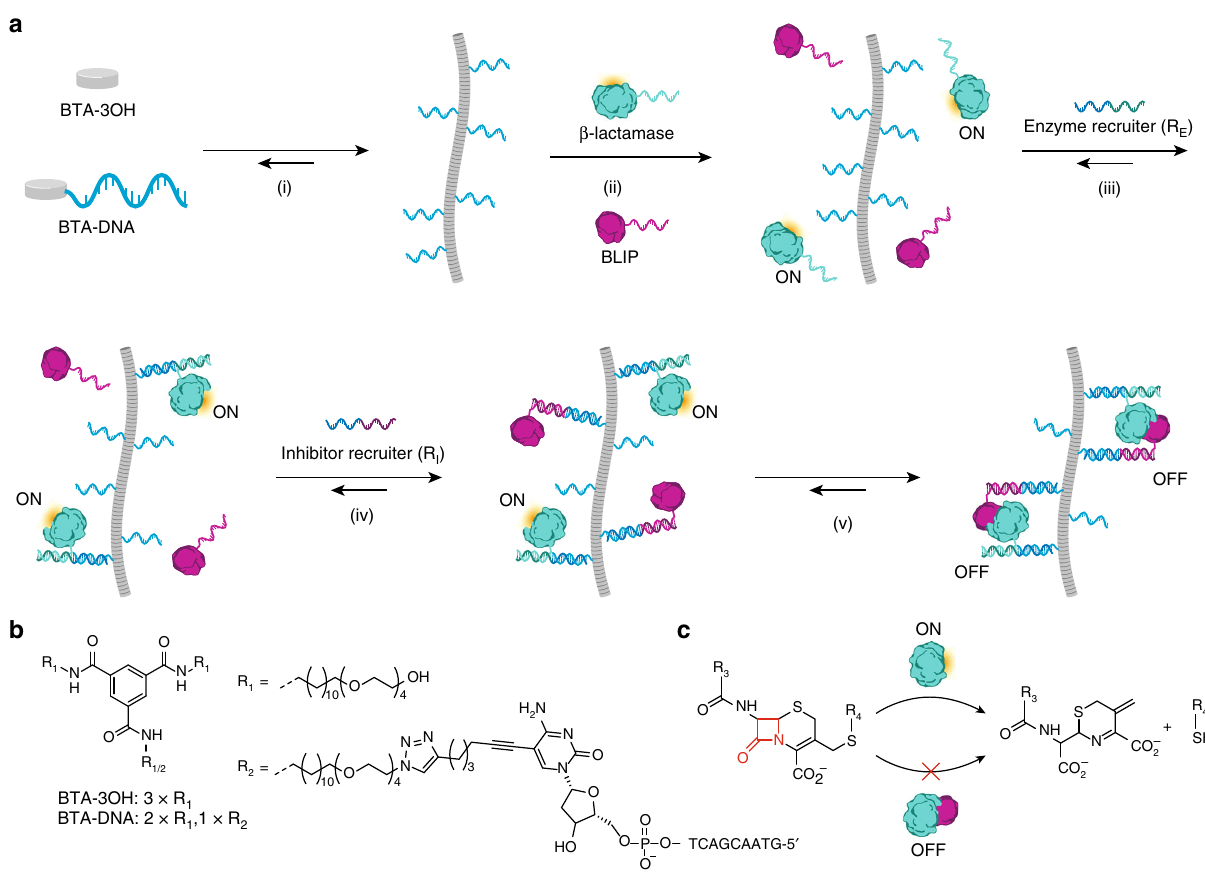
Fig. 1 Recruitment of β -lactamase and BLIP on a supramolecular BTA polymer via DNA hybridization. a Schematic representation of the selective recruitment of proteins to BTA polymers. (i) BTA monomers functionalized with a 10-nucleotide handle strand (BTA-DNA) are co-assembled in a desired ratio with inert BTA monomers (BTA-3OH) to yield supramolecular polymers decorated with DNA receptors. (ii) To allow sequence speci fi c oligonucleotide directed recruitment of the enzyme ( β -lactamase) and its inhibitor protein (BLIP), each protein is functionalized with a unique 21-nucleotide handle strand. (iii) Addition of a speci fi c recruiter oligonucleotide that is complementary to the handle strand on the BTA polymer and the enzyme